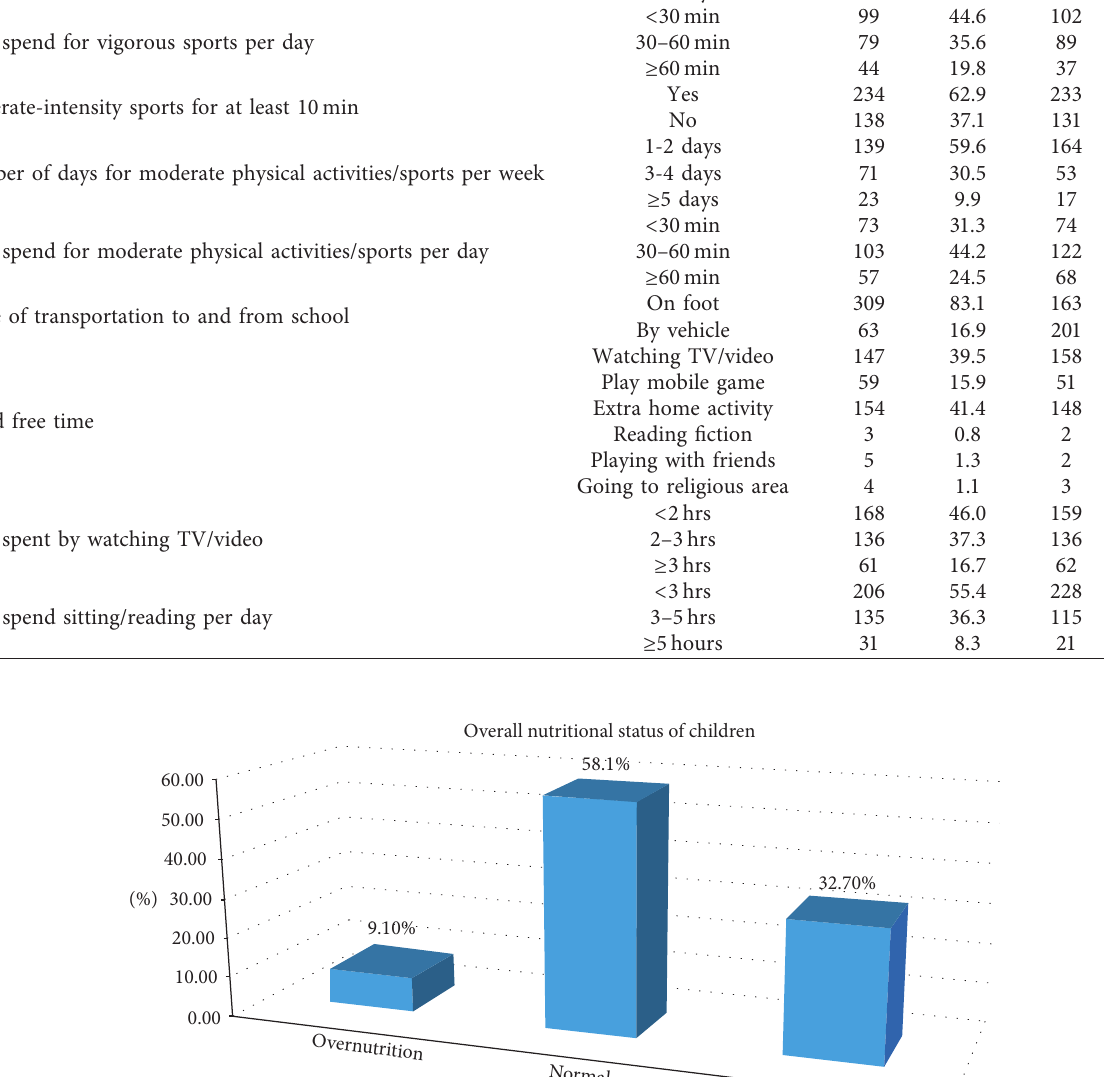
Time spend for moderate physical activities/sports per day Mode of transportation to and from school